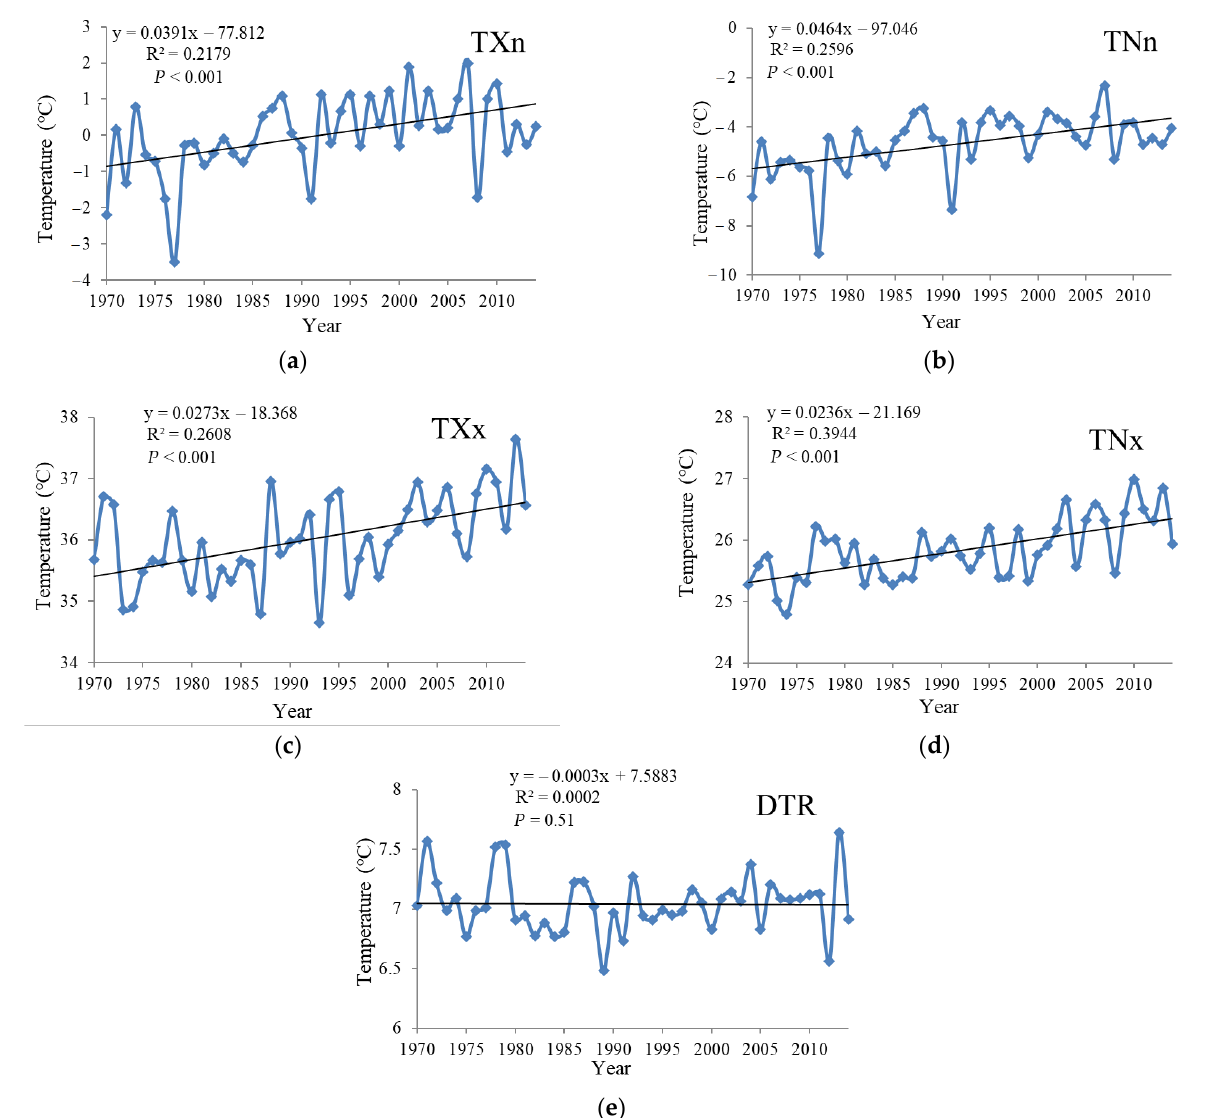
Figure 6. Temporal variation of extreme indices of the extreme temperatures in the Yangtze River Basin from 1970 to 2014. ( a ) is TXn, ( b ) is TNn, ( c ) is TXx, ( d ) is TNx and ( e ) is DTR.